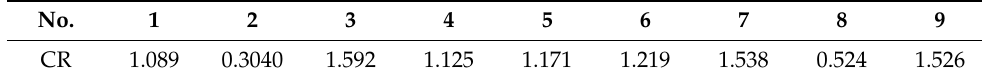
Figure 7. The convergence history of 9 examples. Table 7. The convergence rate (CR) of 9 examples.